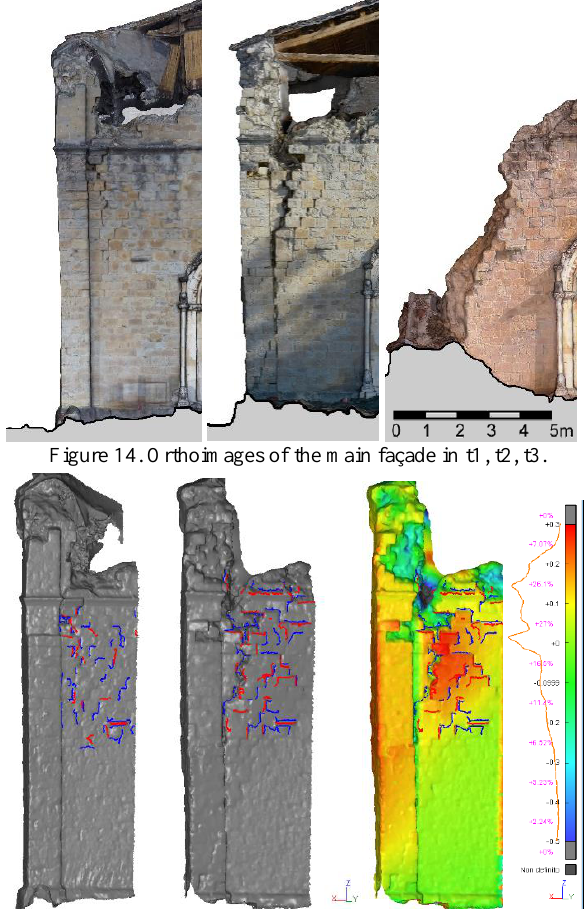
Figure 15. 3D model breaklines detection on t1 and t2; the surface comparison between t1-t2 with appreciable differences Figure 12. Analysis on West wall where the damage of about 0.1-0.3m (more or less 55% on the mechanisms caused the collapse of the central part of the masonry by shear failures.